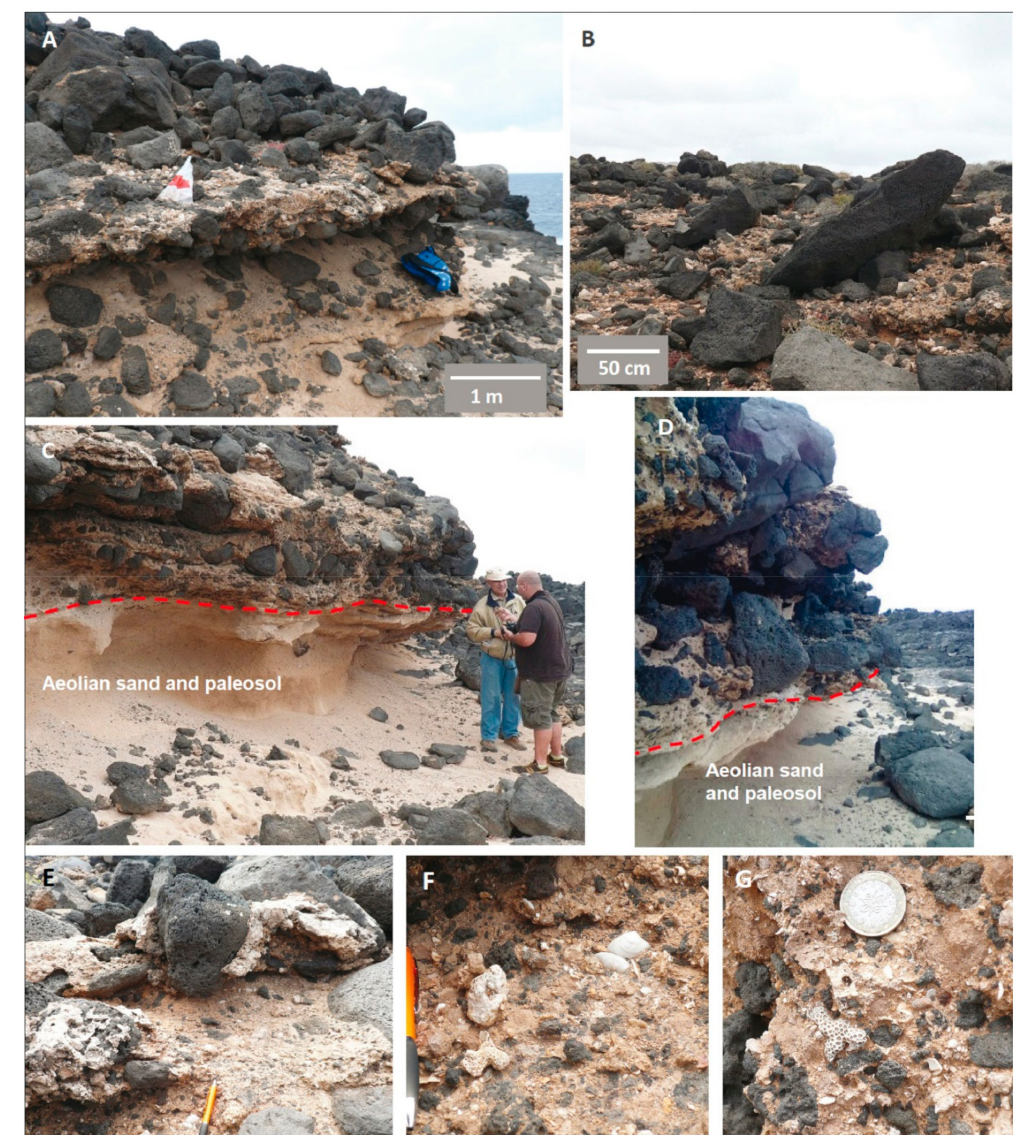
Figure 9. Piedra Alta tsunami deposits. ( A , C ) Marine conglomerate (4 m thick max.) overlying dune sands and clayey paleosols containing terrestrial fauna (the red line marks the base of the tsunami deposit); ( B ) imbricated large boulders indicating landward flow, bigger block 1.5 m-long; ( D ) view of a 1.5 m-thick section of the deposit with large angular basalt boulders upwards; ( E ) basalt angular to sub-rounded clasts set in a bioclastic sandstone matrix, with a clast- to matrix-supported texture; ( F , G ) marine fossil content: coral fragments and mollusk shells and